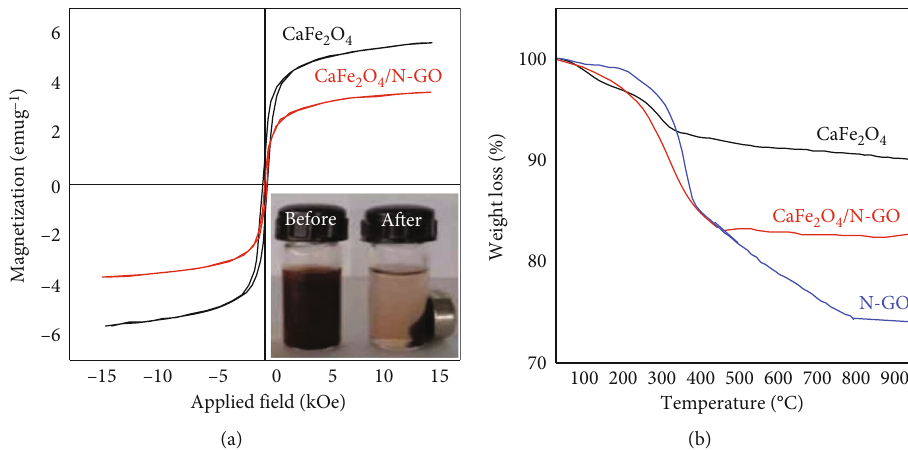
O /N-GO nanocomposite (inset: the magnetic 2 4 O nanoparticles, N-GO, and CaFe 2 4